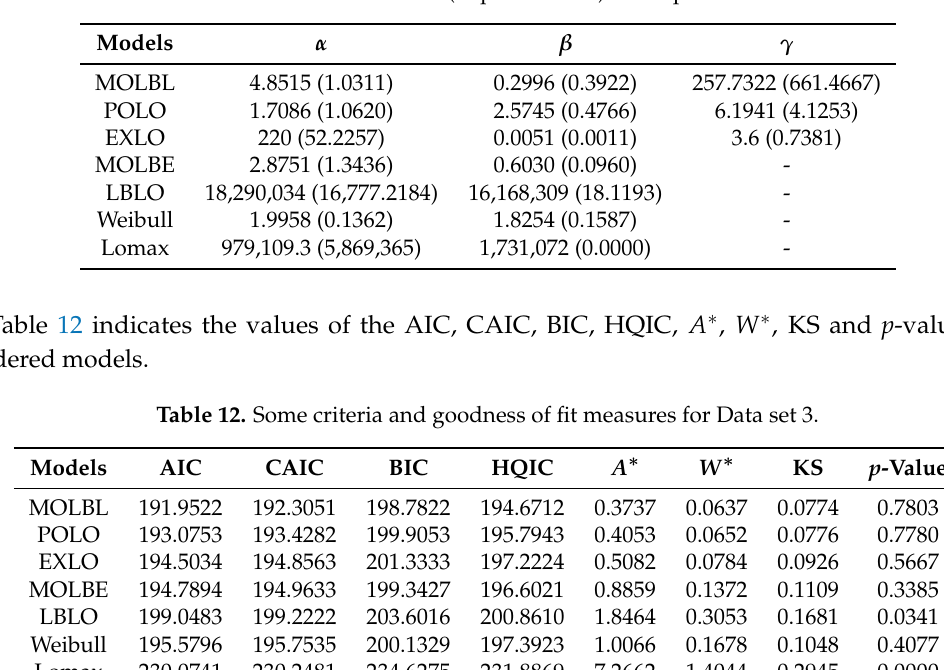
Table 11. Estimates and standard errors (in parentheses) of the parameters for Data set 3.